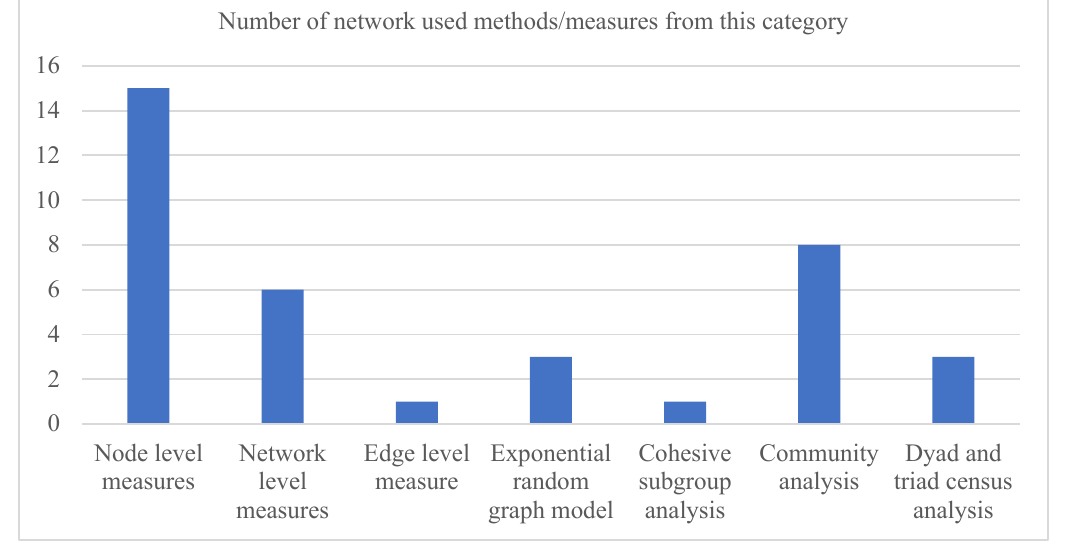
Figure 4. Frequency of different network measures and methods that were used by the 29 articles considered in this study. Some of these articles employed network measures and methods from more than one category.